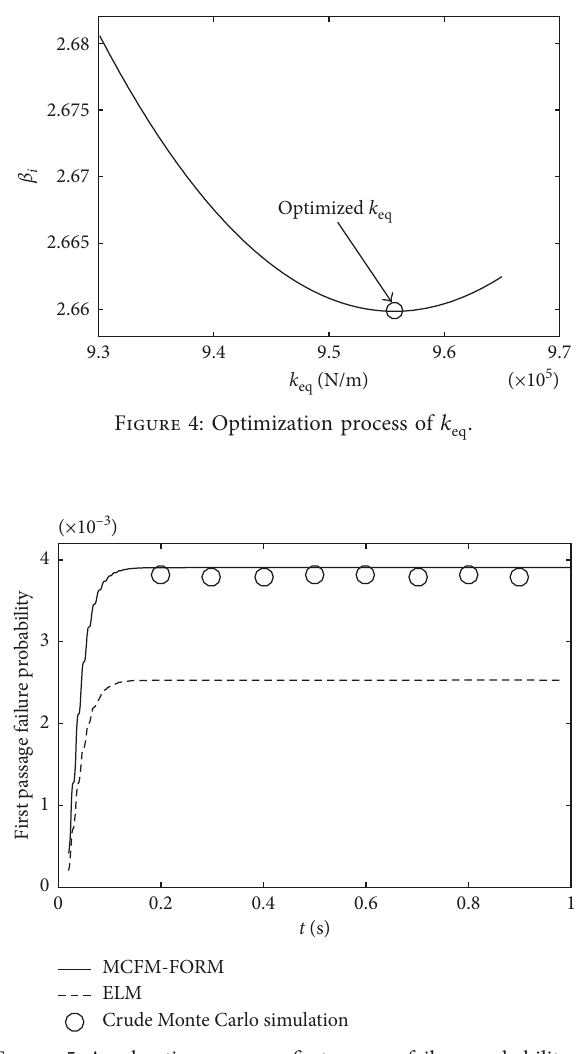
Figure 5: Acceleration response first passage failure probability of the nonlinear